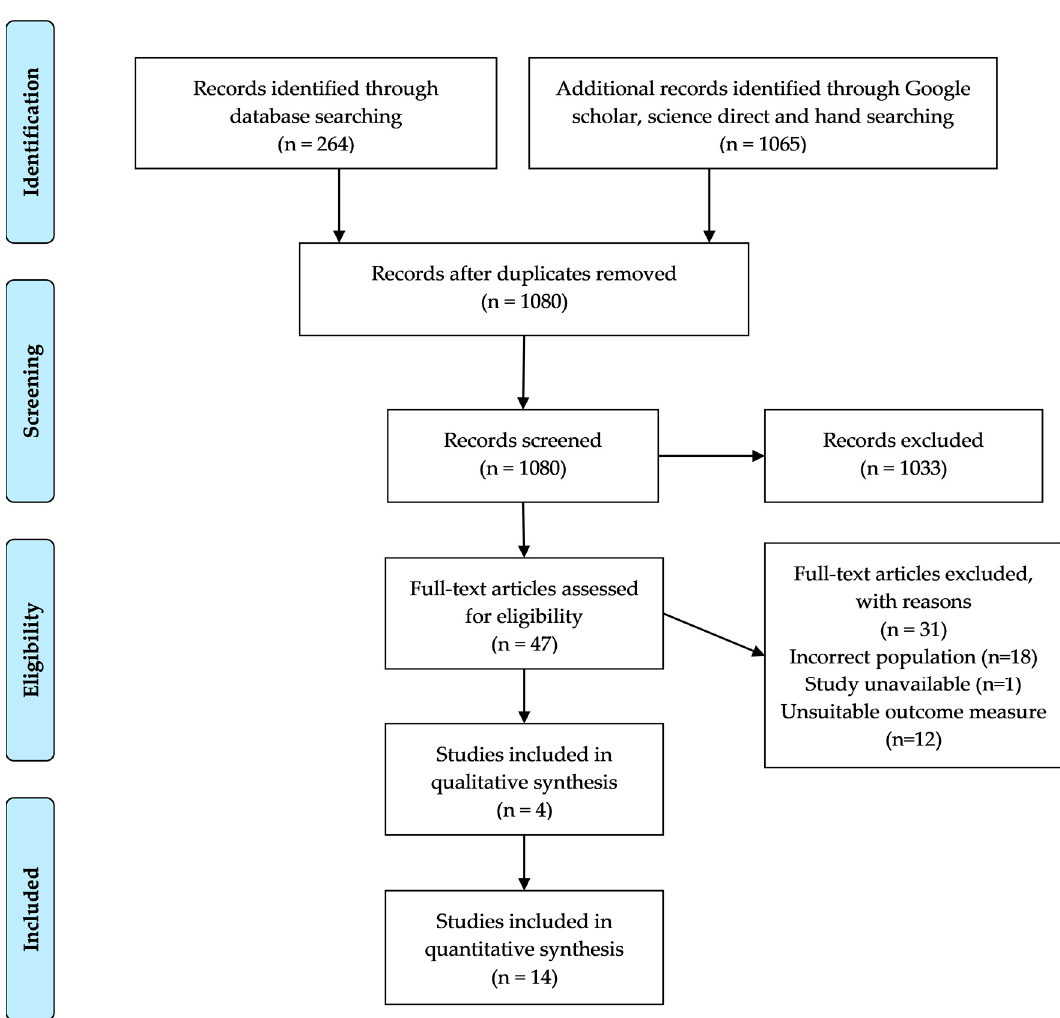
Figure 1. PRISMA Flow Diagram adapted from Moher [41].